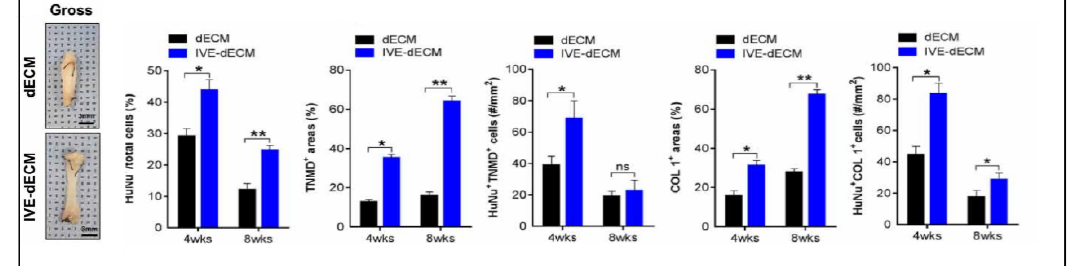
Figure 15. Gross images of dECM and in vitro stimulated dECM (IVE-dECM) tendon scaffolds. Characterization of cell area, TNMD, and COL-1 expression of dECM (black) and IVE-dECM (blue) tendon scaffolds after 4 and 8 weeks post-surgery is shown. (* p < 0.05 and ** p < 0.01). Adapted from [81].